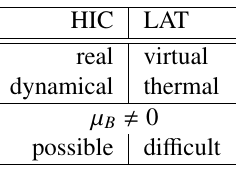
Table 1. Short summary of the charcteristics of the HIC and